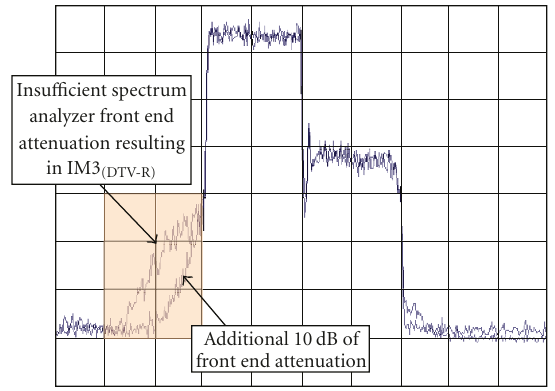
Figure 12: Example of IM 3(DTV-R) using an improperly configured spectrum